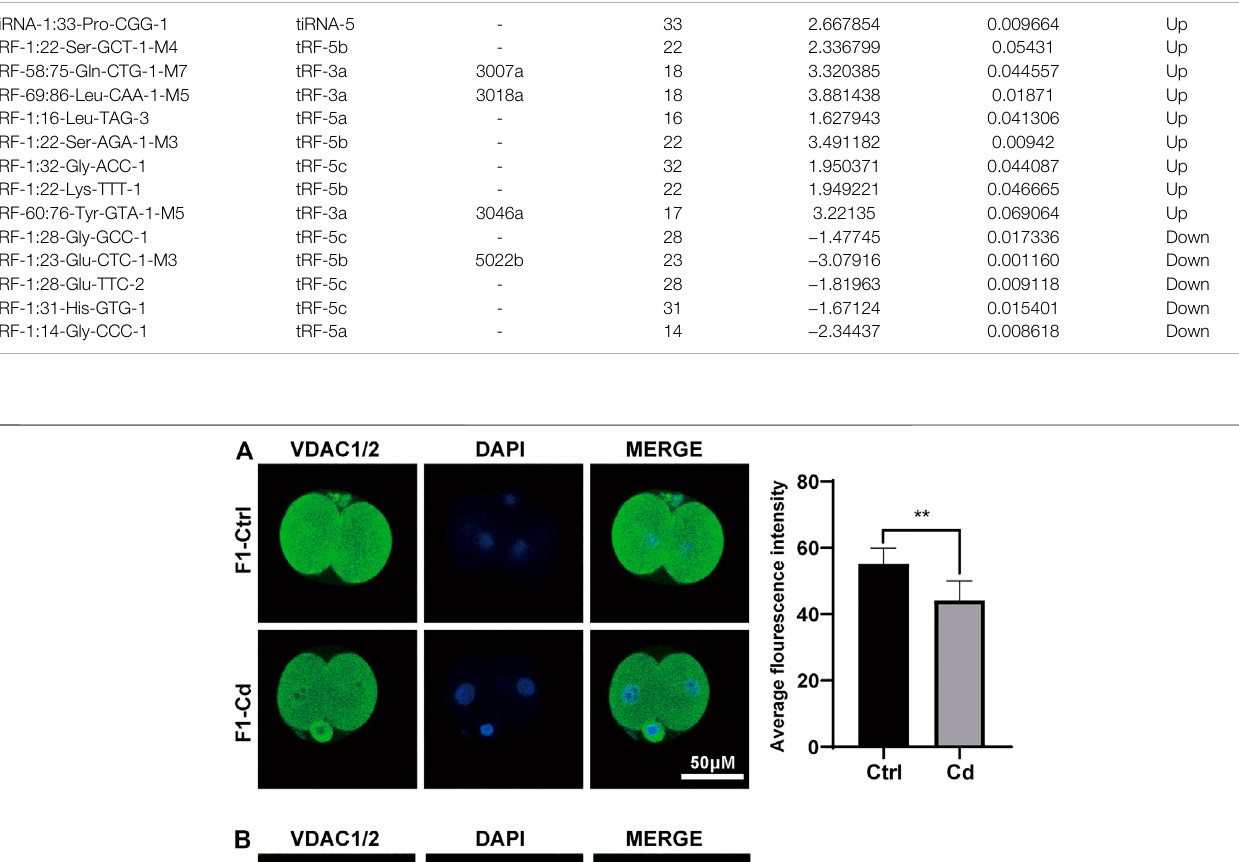
TABLE 2 | The candidate tsRNAs selected for bioinformatics tsRNA_ID Type